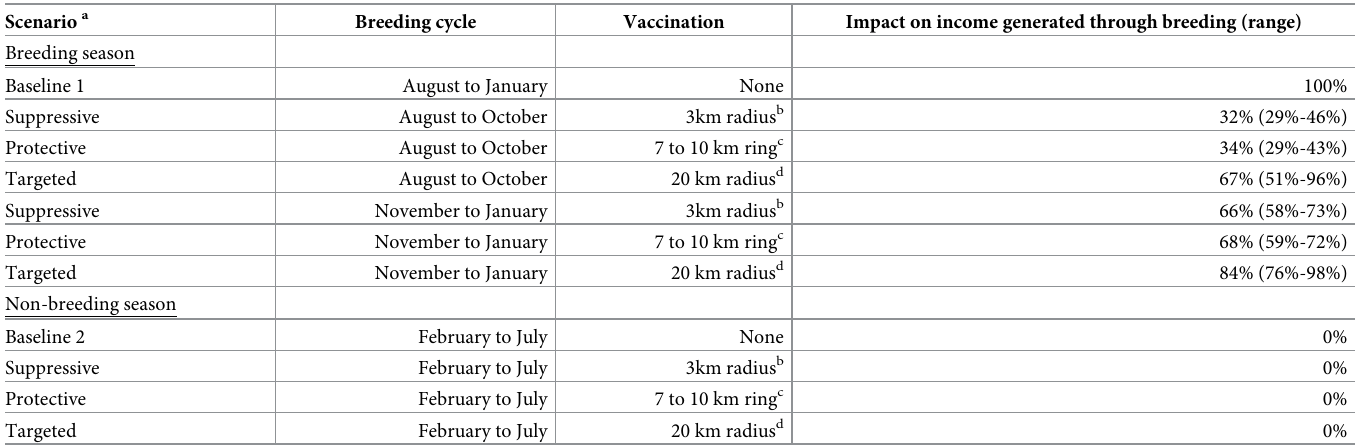
Table 1. Description of the breeding season adjusted baseline and alternative control strategies for an equine influenza outbreak in New Zealand.